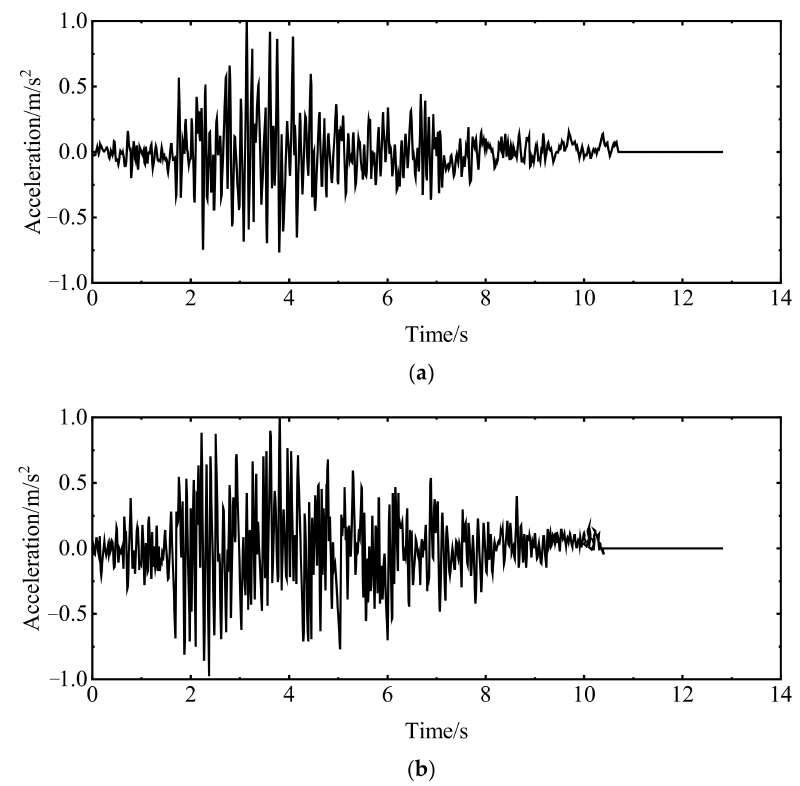
Figure 18. Time history of seismic acceleration: ( a ) horizontal and ( b ) vertical.